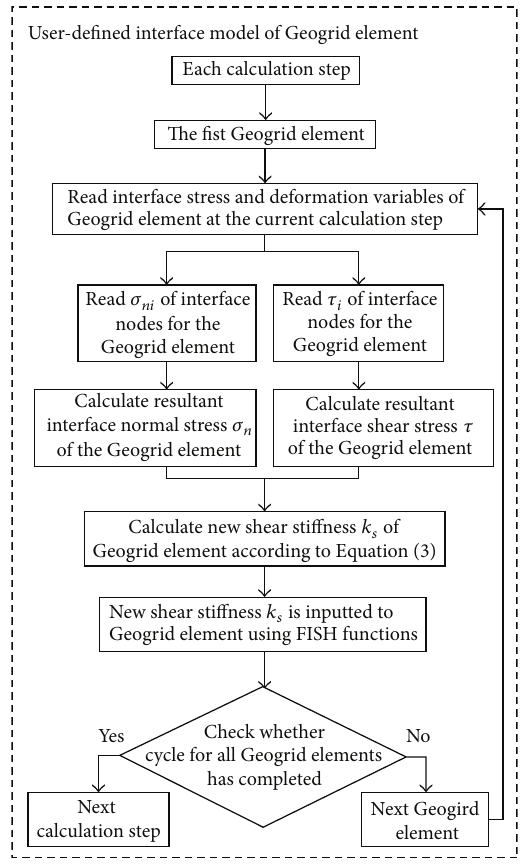
Figure 11: Program flow chart of user-defined interface model of Geogrid element.